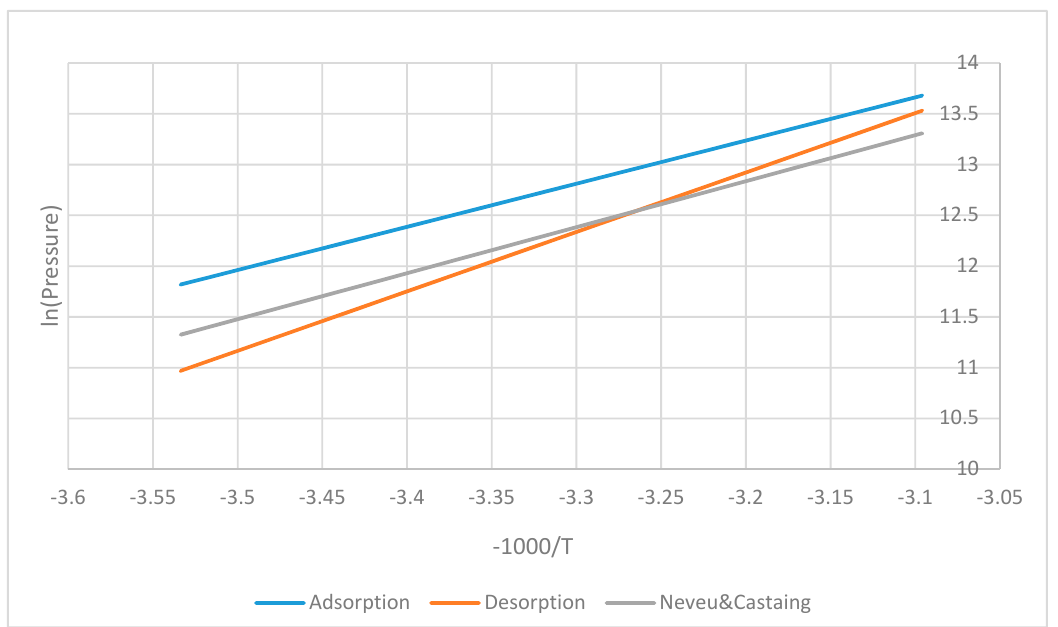
Figure 4. Calculated equilibrium lines compared to data by Neveu and Castaing attributed to a thesis by S. Mauran (1982) Perpignan [8].